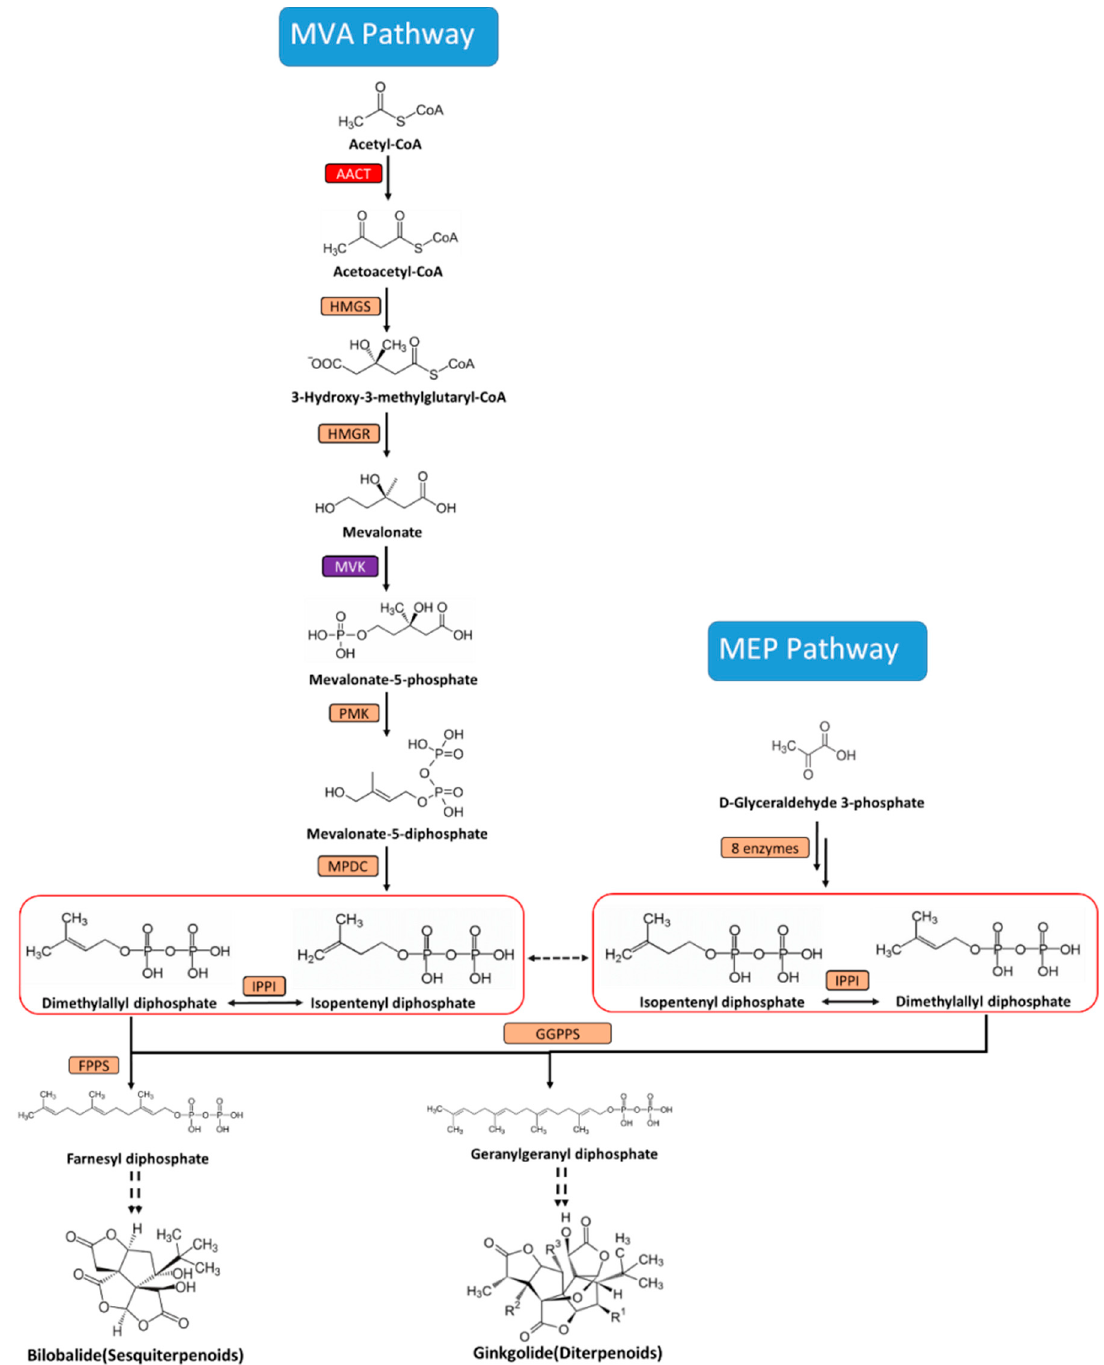
Figure 1. The biosynthetic pathway of ginkgolides and bilobalide in Ginkgo biloba . MEP: